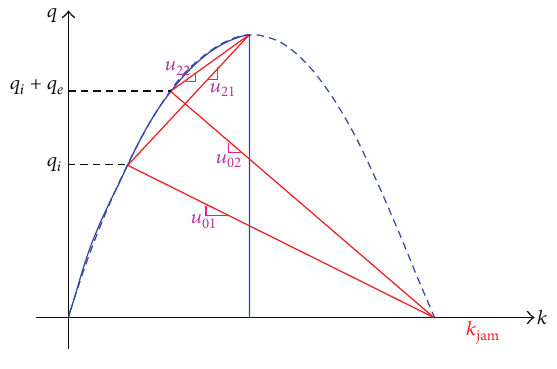
Figure 19: Fundamental